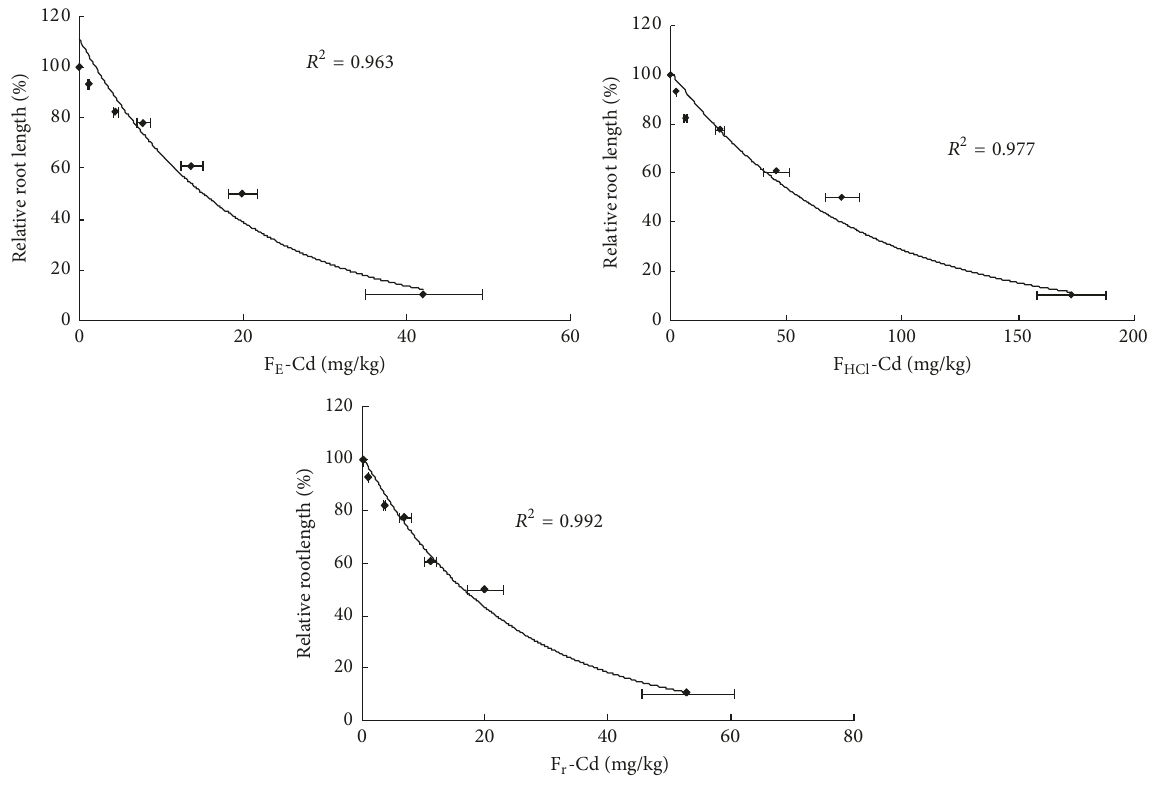
Figure 4: Regression between RRL (%) and the chemical forms of Cd.